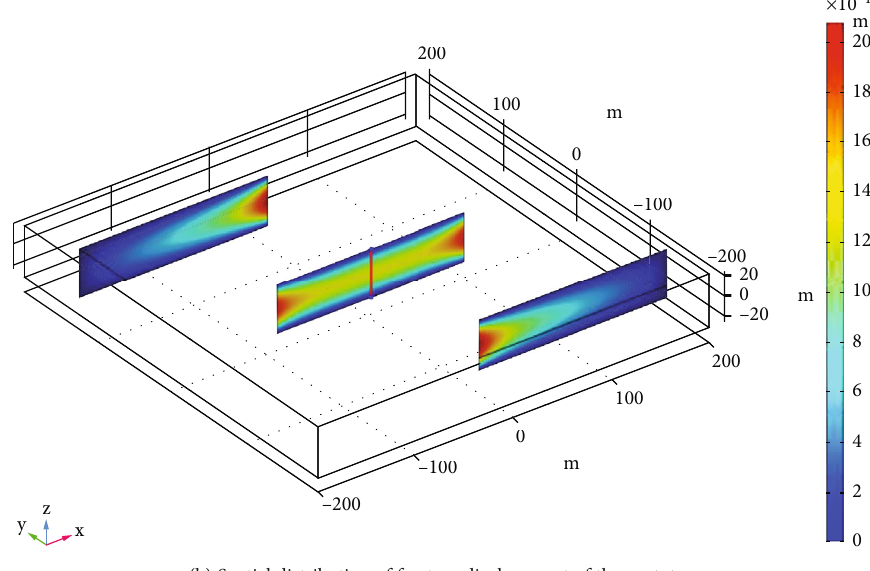
Figure 6: Spatial distributions of fracture displacement of the prototype and the